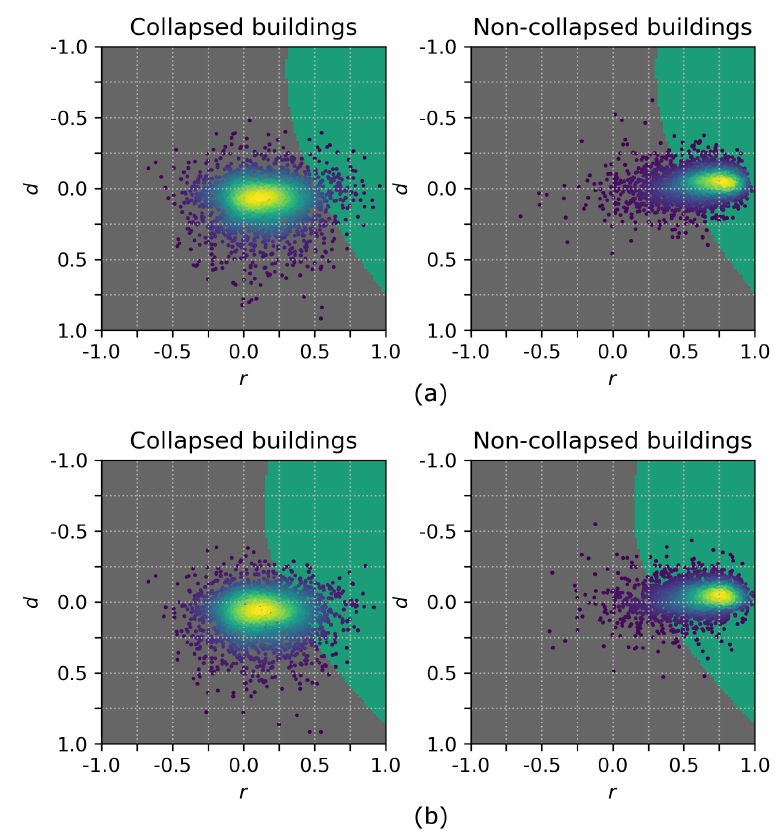
Figure 6. Non-linear discriminant functions calculated from the fragility functions of ( a ) Koshimura et al. [26] and ( b ) Suppasri et al.